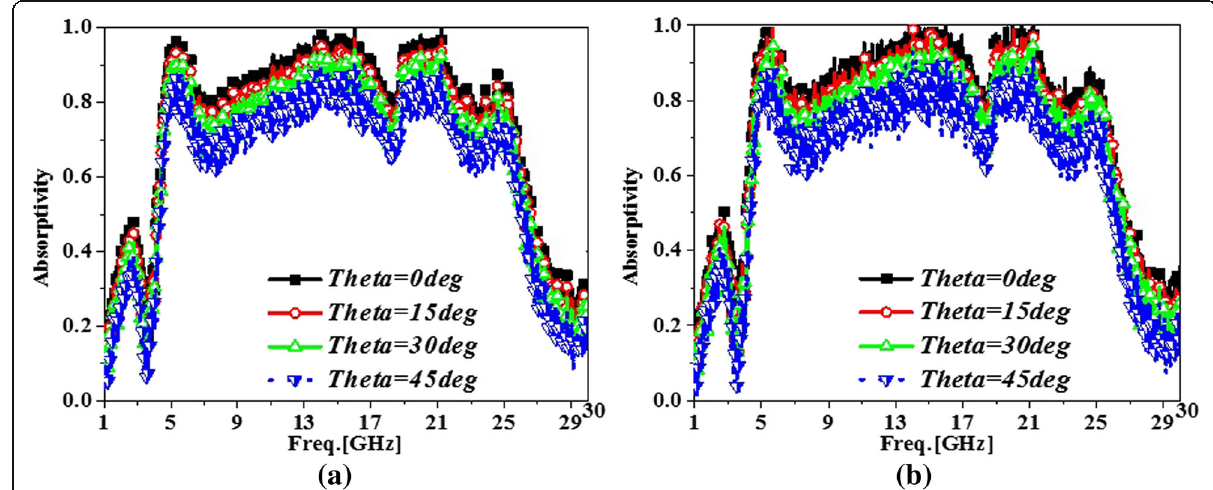
Fig. 9 The experimental absorption for the proposed ultra-broadband PMA devices when the incident angle ( θ ) shifted from 0 to 45° in the x -polarized and y -polarized incidences. a The experimental absorption results of the PMA sample with θ of 0°, 15°, 30°, and 45° in the x -polarized incident waves. b The experimental absorption results of the PMA sample with θ of 0°, 15°, 30° and 45° in the y -polarized incident